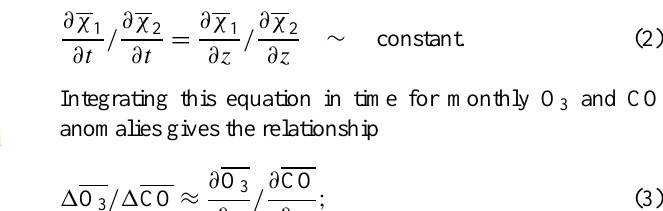
ents for O 3 and CO. These strong relationships between di- abatic heating ( Q ) and tracer anomalies highlight the dom- inant role of tropical upwelling in controlling species with strong vertical gradients near the tropical